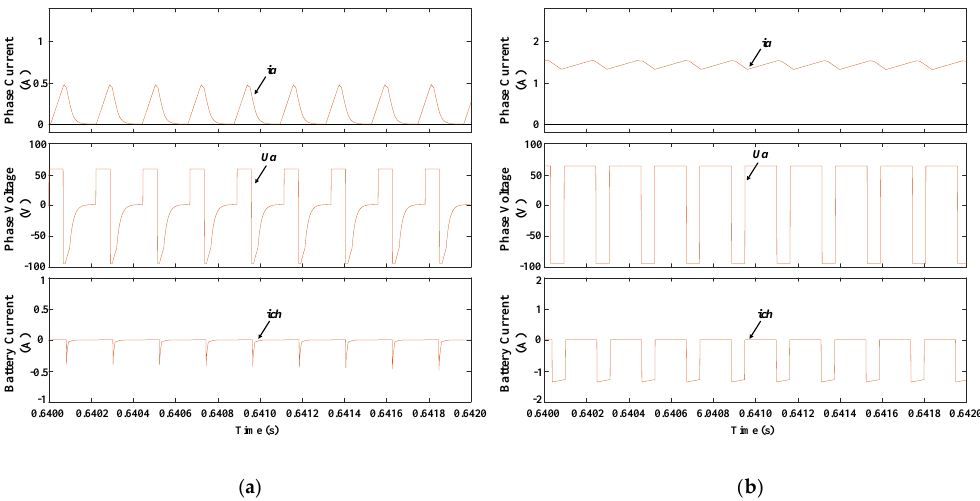
Figure 9. The simulation waveforms of the static charging mode. ( a ) At 30% duty cycle. ( b ) At 70% duty cycle.